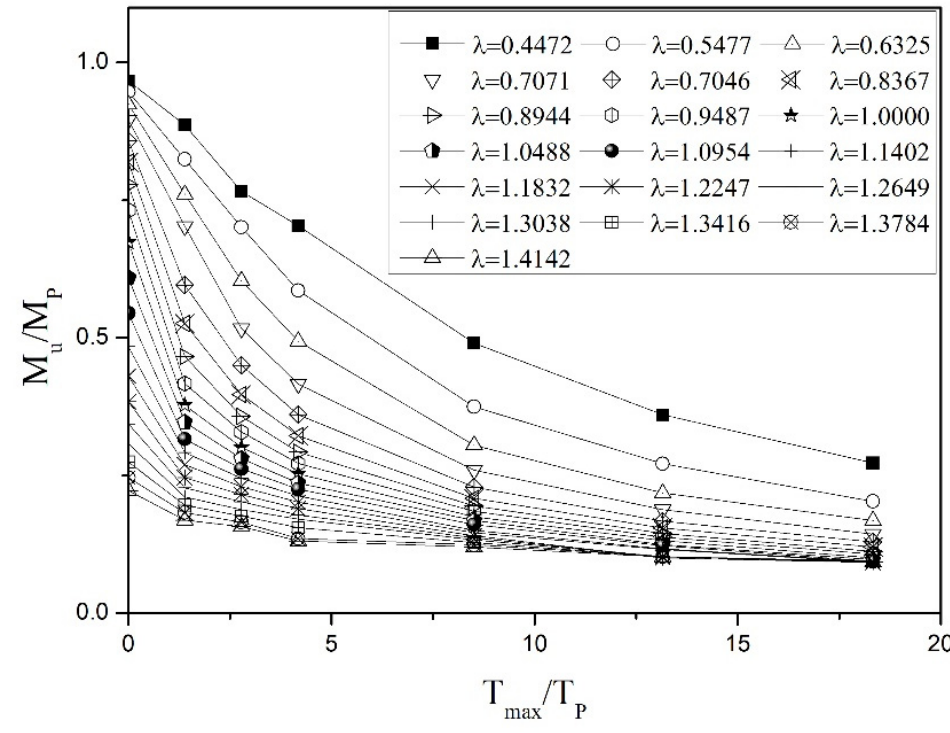
Figure 8. Bending–Torsion Interaction Curves.